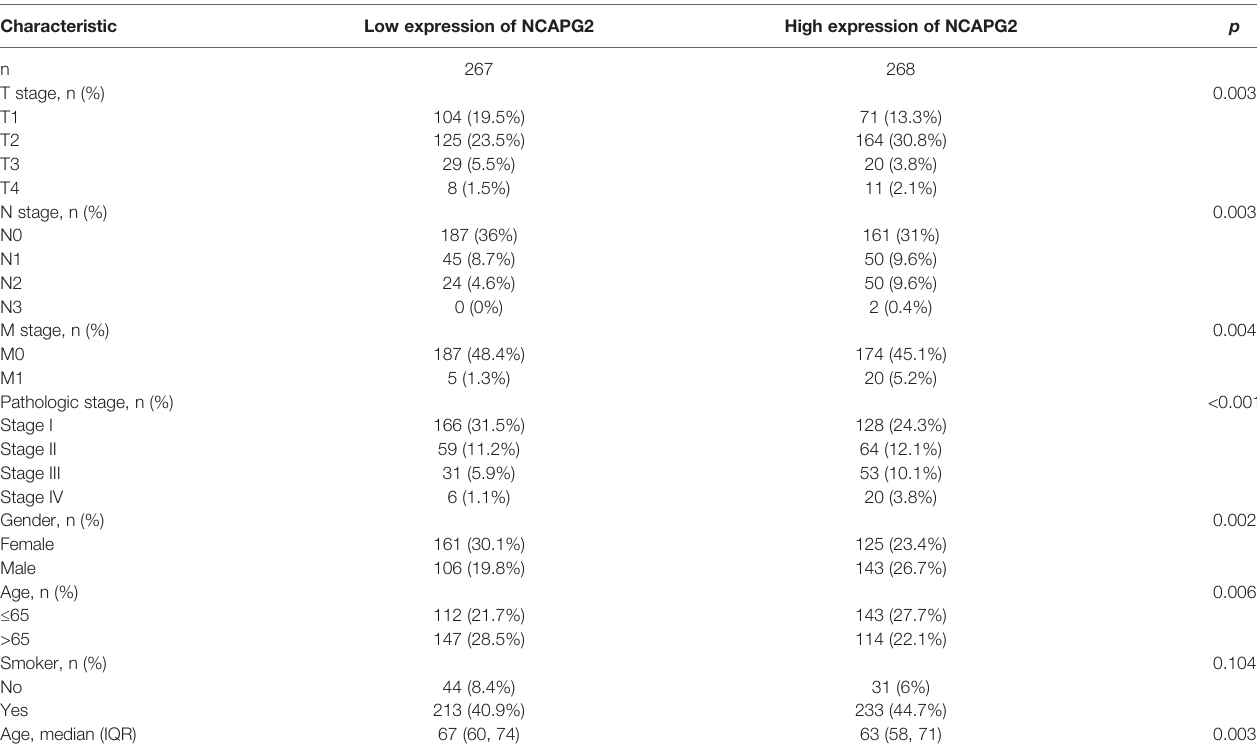
TABLE 1 | Clinical characteristics of the LUAD patients. Characteristic